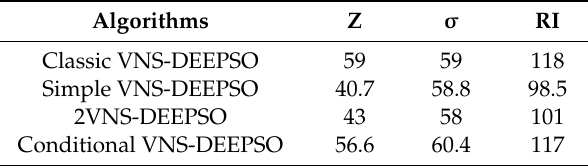
Table 5. Strategies according to the objective